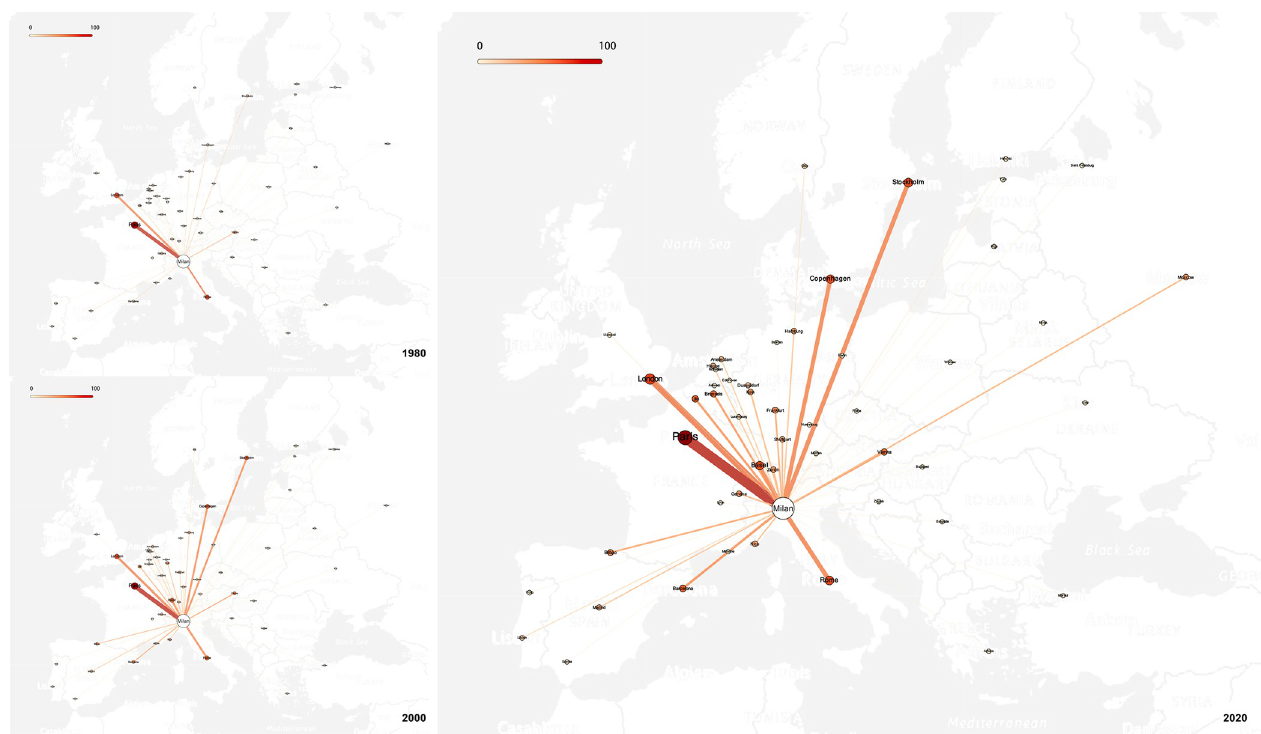
Fig 5. Inward interlocking between Milan and other cities. (Base map source: USGS National Map Viewer (public domain)).